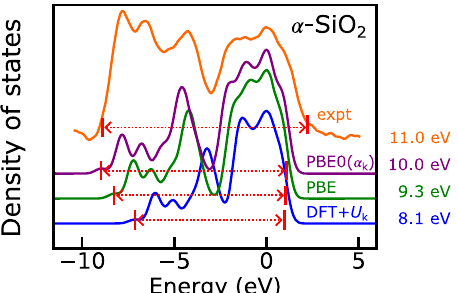
Fig. 3 Band widths obtained with various functionals. Density of valence band states for α -SiO 2 as calculated with PBE0( α k ), PBE, and DFT + U k , compared with the experimental XPS spectrum from ref. 89 . The corresponding band widths are indicated. The theoretical band widths correspond to differences between Kohn-Sham levels, whereas the experimental band width is obtained from extrapola- tions of the wings. The curves are aligned with respect to the position of the highest energy peak.